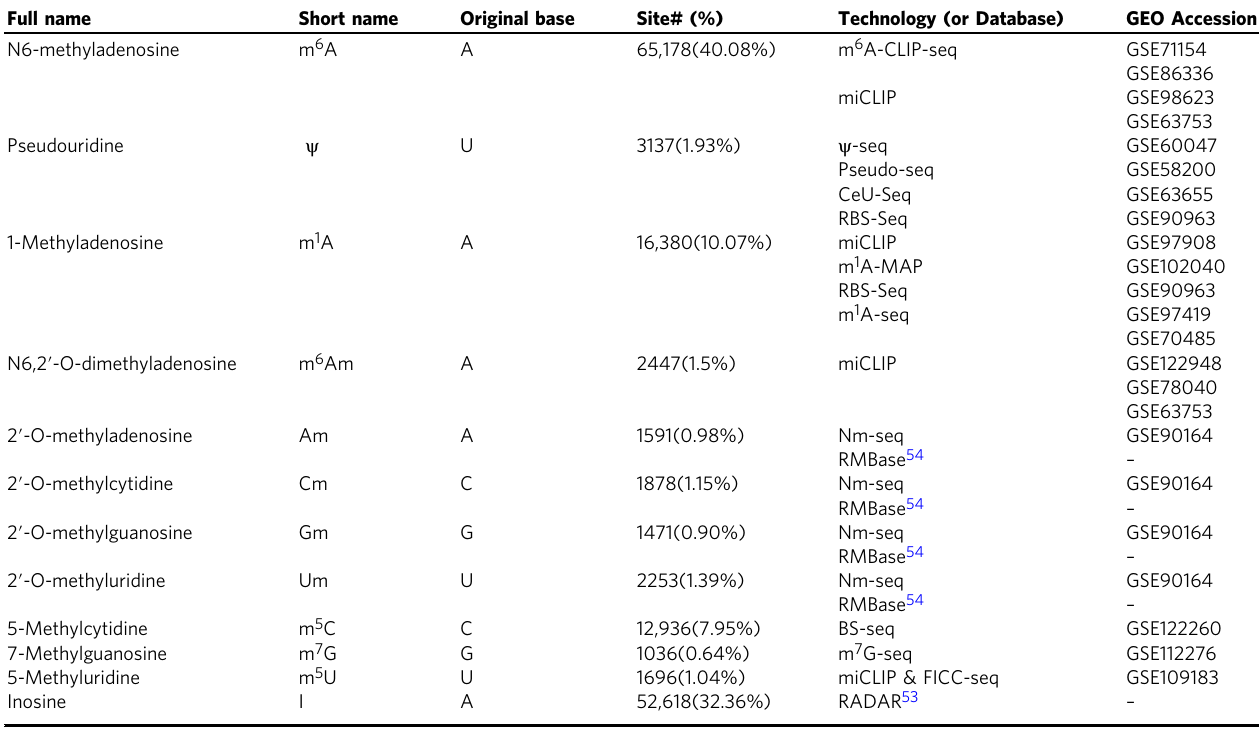
Table 5 List of base-resolution epi-transcriptome pro fi ling